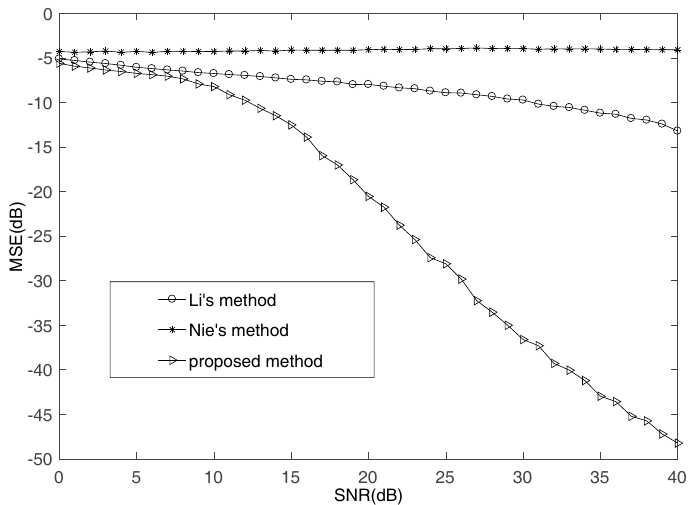
Figure 2. The MSE comparisons of different methods.